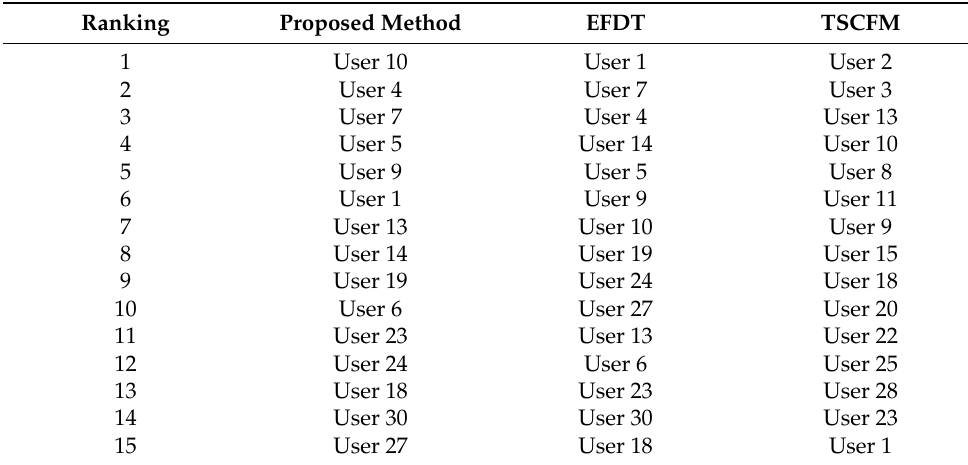
Table 3. Expert recommendation results.